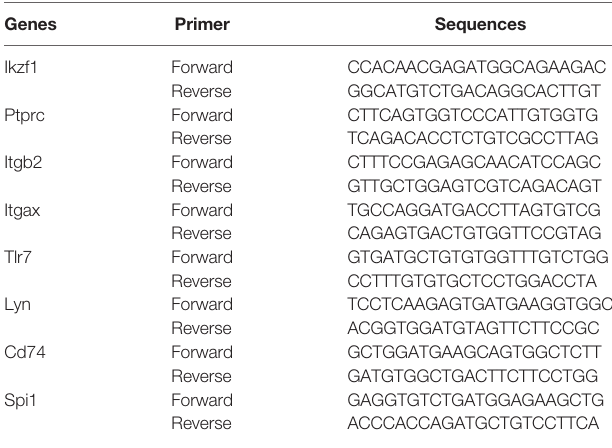
TABLE 2 | Primers for Hub